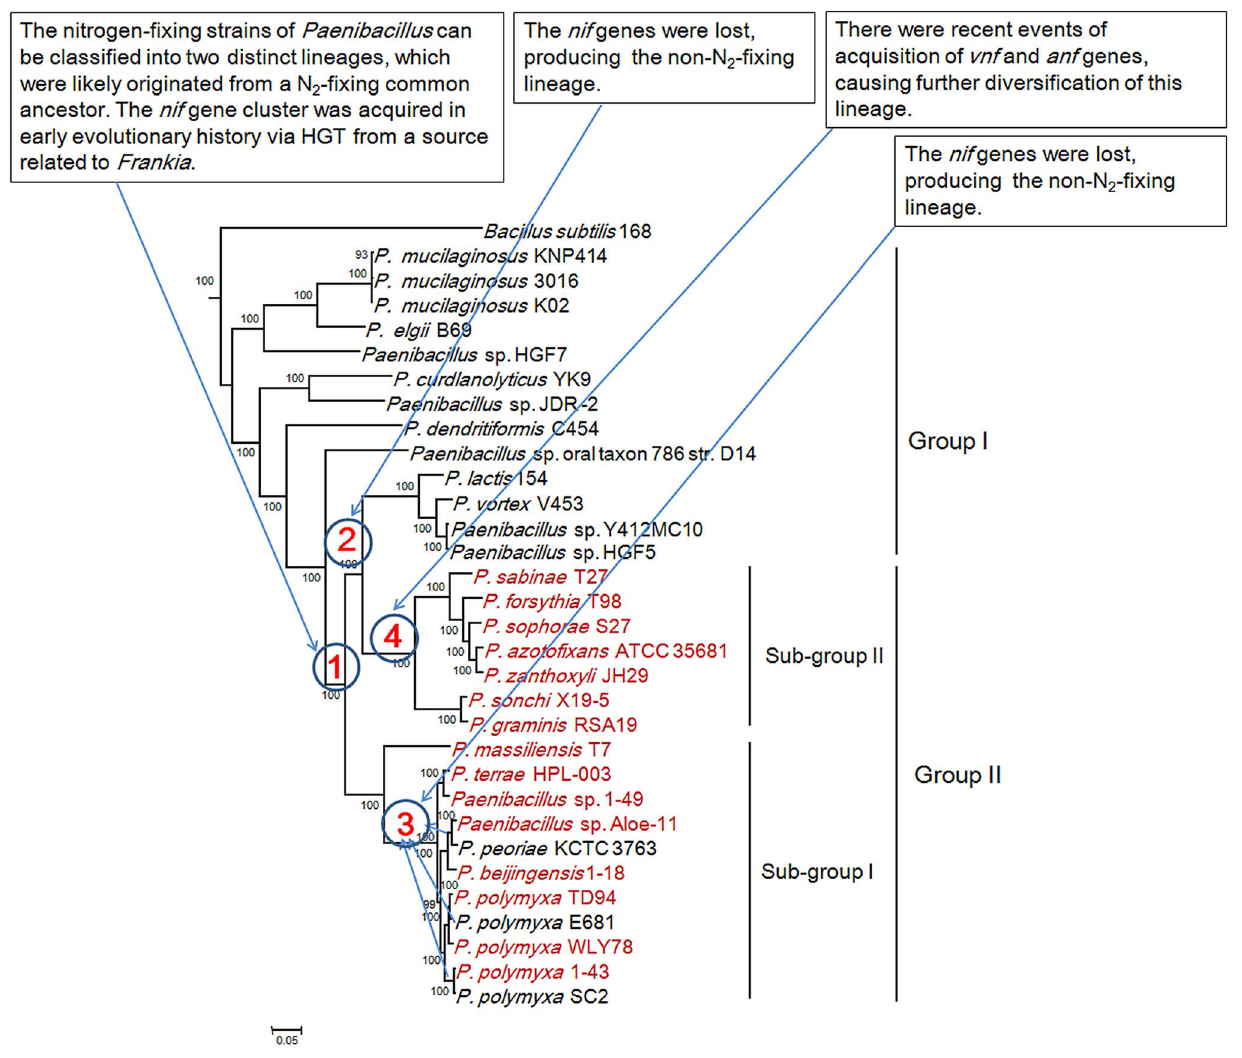
Figure 7. Maximum-likelihood phylogenetic tree of Paenibacillus strains and the 4 possible evolutionary pathways of nitrogen fixation in Paenibacillus . The tree was constructed based on 275 single-copy core proteins shared by the 31 Paenibacillus genomes and the rooting strain B. subtilis 168. Four likely pathways are marked with number 1–4.